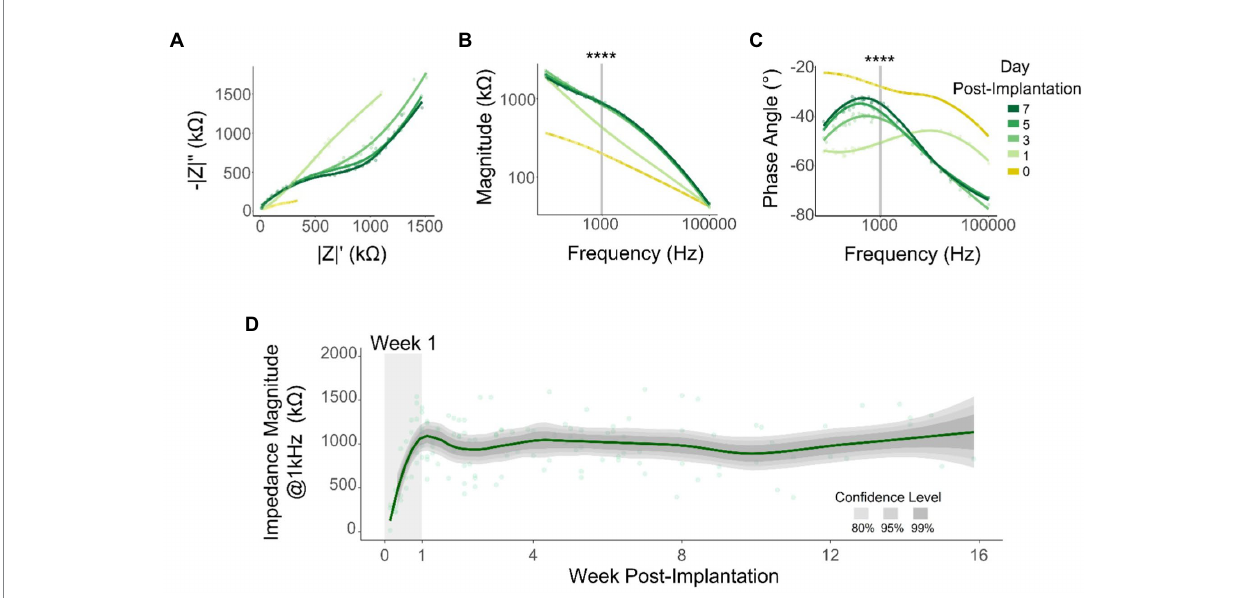
FIGURE 5 Electrical impedance over time. Representative changes in impedance during the first week post-implantation: Nyquist (A) , impedance magnitude (B) , and phase angle (C) . Shaded lines indicate data points at 1 kHz that were used for statistical comparison (Kruskal–Wallis test) for all tested channels ( n = 545). (D) Mean impedance magnitude at 1 kHz over time. Line represents a locally fitted polynomial regression of the means and shaded areas represent confidence intervals ( N = 6). **** p ≤